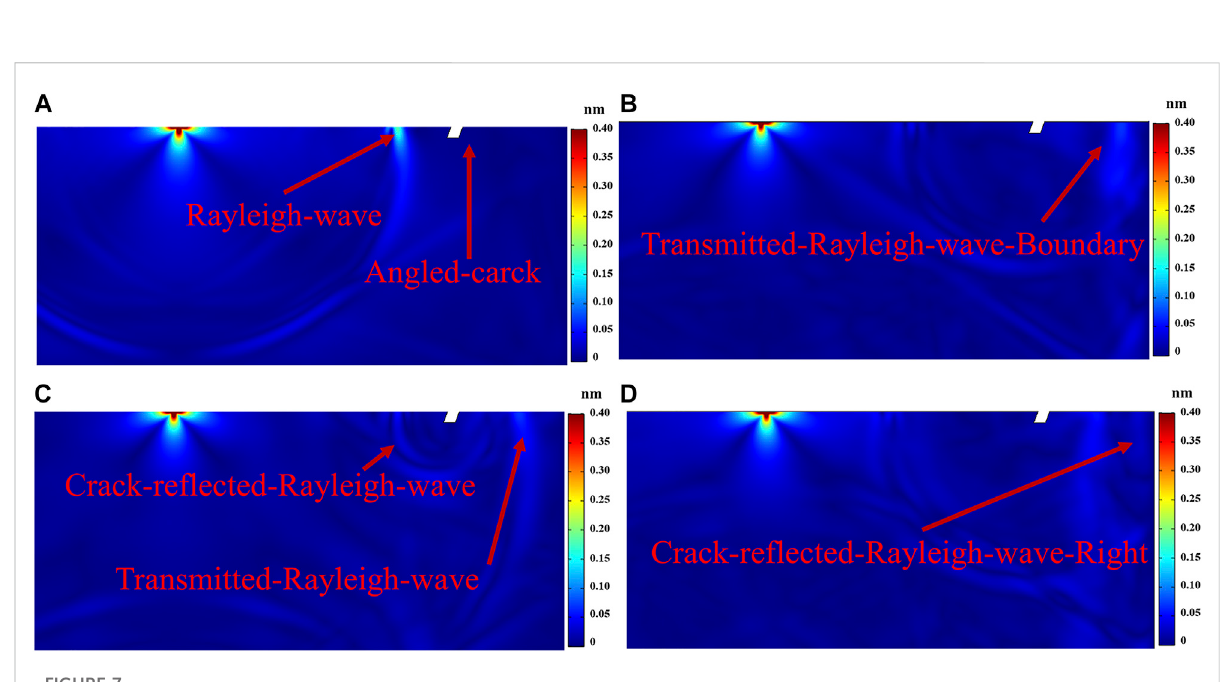
FIGURE 7 Rayleigh waves at different times: (A) 2.0 μ s; (B) 3.1 μ s; (C) 3.75 μ s (D) 4.0 μ